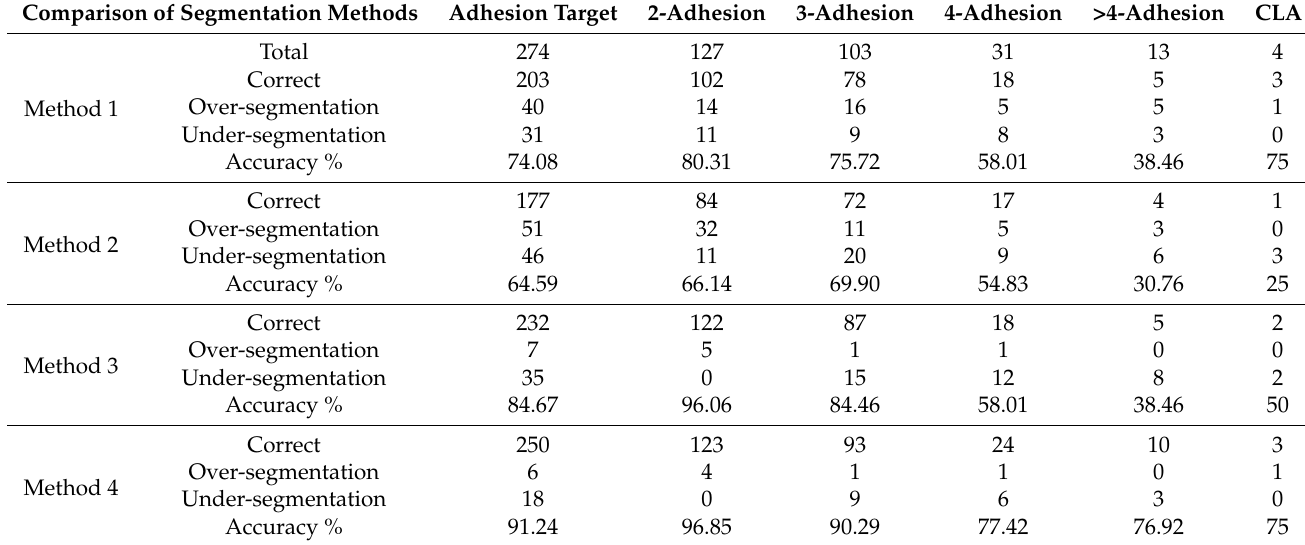
Table 1. Segmentation results in overlapping and adhesion